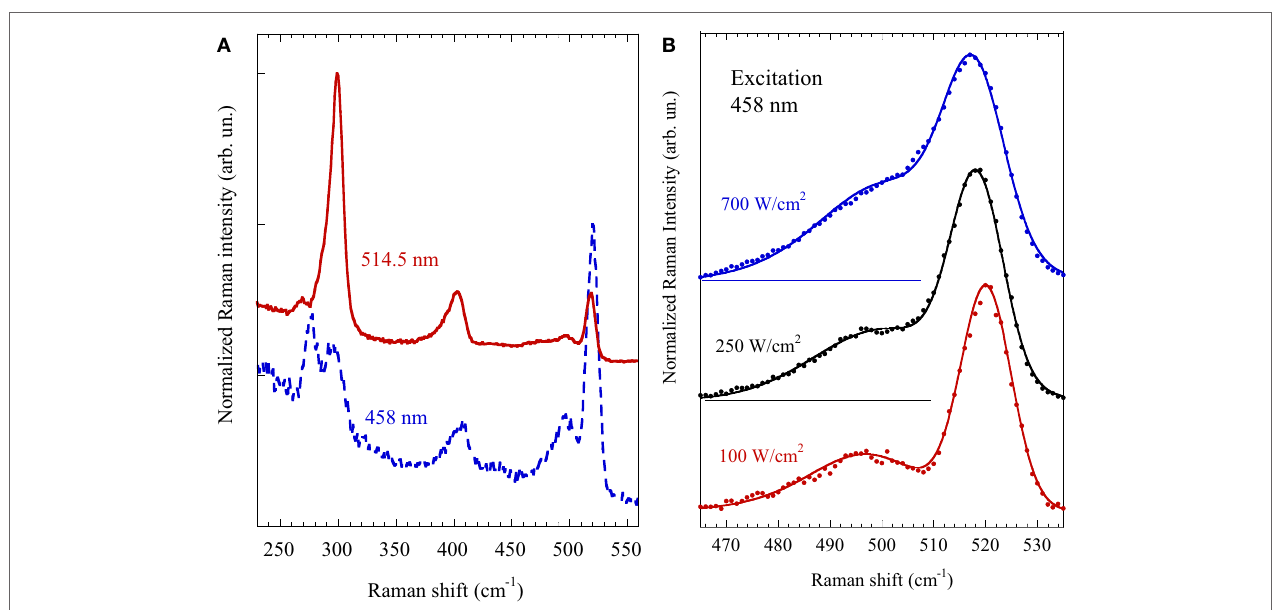
FiGURe 7 | (A) Raman spectra of Si/Ge NW HJs obtained under different (indicated) excitation wavelengths. (B) Background-corrected Raman spectra obtained under 458 nm wavelength excitation and different (indicated) excitation intensities (Wang et al., 2015). Note that the second Raman peak around 270 cm − 1 under 458 nm excitation is, most likely, associated with a laser plasma line.